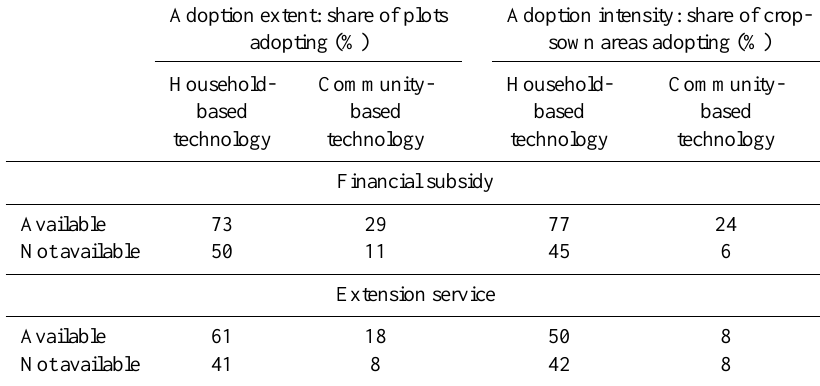
Percentage of crop sown areas (%) Data source: authors’ survey. Table 3. Relationship between governmental support and adoption of modern irrigation technology in China, 2010. Adoption extent: share of plots Adoption intensity: share of crop- adopting (%) sown areas adopting (%) Household- Community-